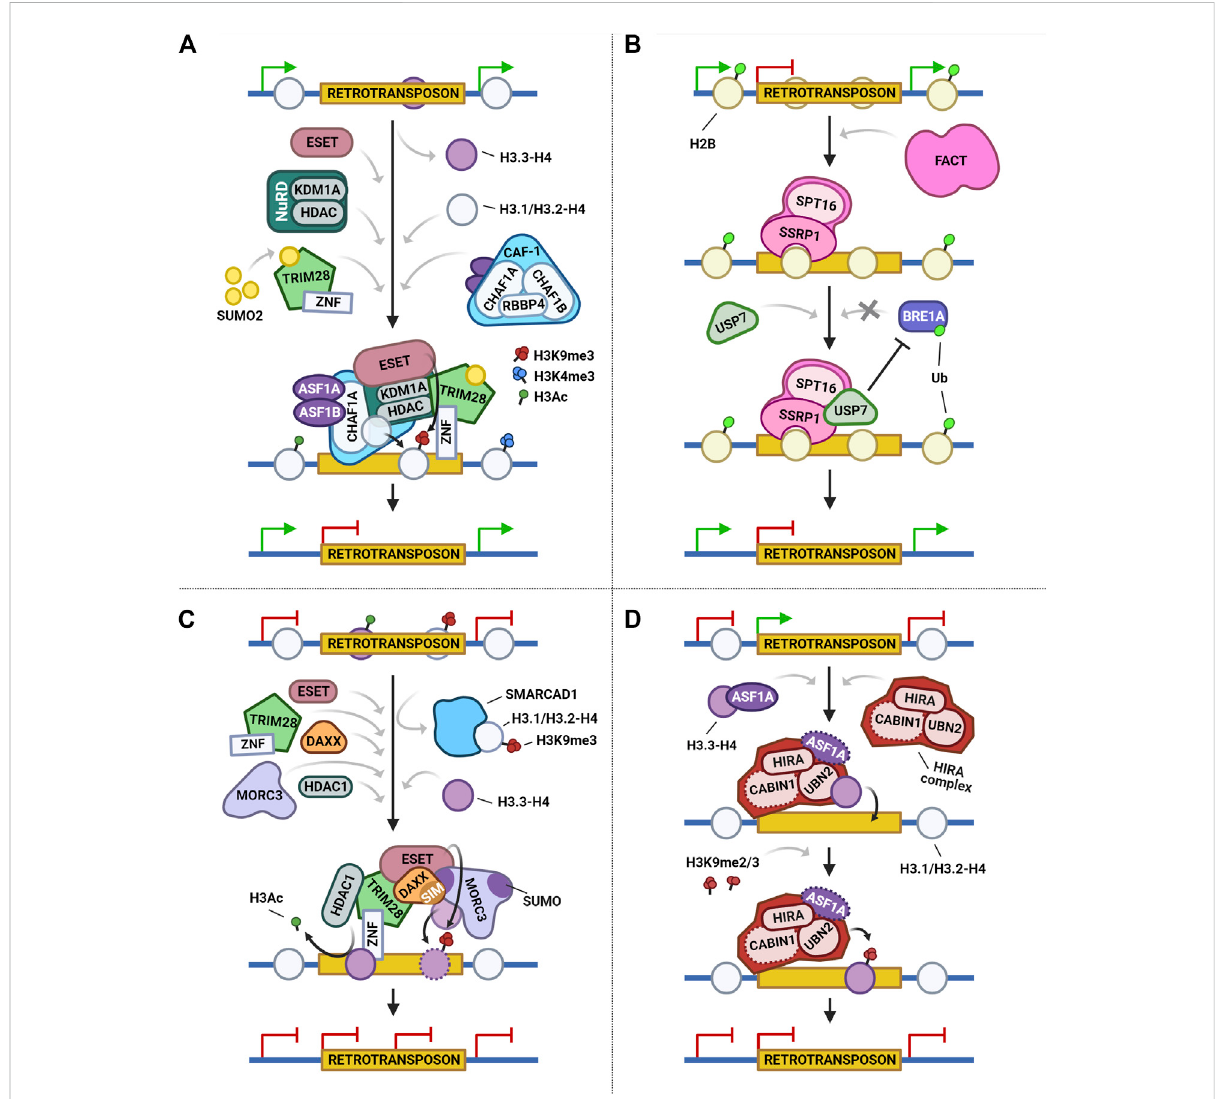
FIGURE 2 Four main histone chaperones show diverse and dynamic mechanisms for the repression of retrotransposon activity. (A) During retrotransposonregulation,theCAF-1complexanditshistonechaperonesASF1A/BpromotethedepositionofhistonedimerH3.1/H3.2-H4tomark integrated proviral retrotransposons. Localized transcriptional repression is then reinforced by members of the NuRD complex and ESET, which results in reduced H3K4me3 and H3Ac marks. SUMO2 sumoylates TRIM28, which is then recruited onto the proviral DNA and promotes the deposition of the repressive H3K9me3 mark. (B) The SRRP1 subunit of the FACT complex binds to retrotransposons and interacts with the SPT16 subunit and H2B deubiquitinase USP7. USP7 suppresses BRE1A, and decreases H2BK120ub deposition, thus repressing the expression of retrotransposons. (C) In DAXX-mediated retrotransposon regulation, TRIM28 is fi rst recruited by KRAB-ZFPs (ZNF) and orchestrates heterochromatin formation and maintenance by recruiting ESET, DAXX, and SMARCAD1. SMARCAD1 activity leads to the eviction of existing